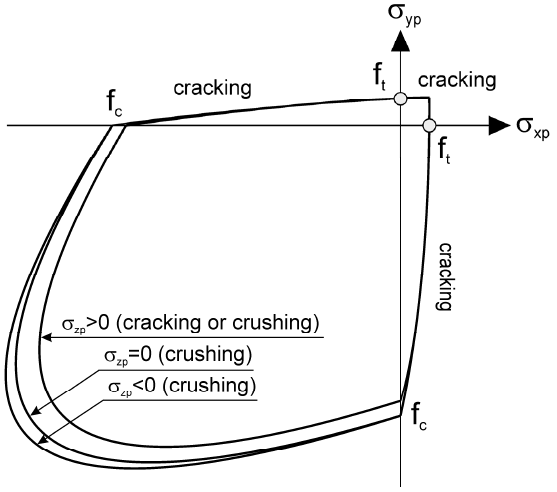
Figure 8. Failure surface with biaxial stress.